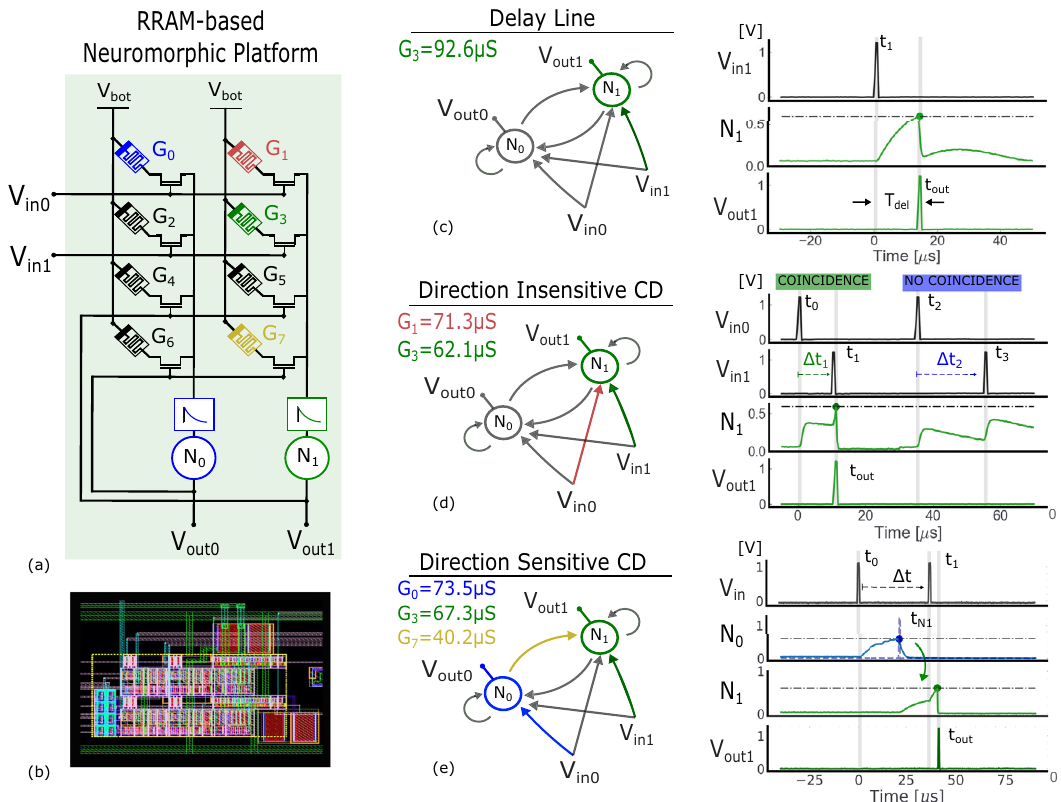
Fig. 4 Experimental measurements of the RRAM-based neuromorphic circuital platform. a Diagram of the circuit formed by two output neurons, N 0 and N fi ne the synaptic connections from inputs to outputs and the four cells on the 1 , receiving two inputs 0 and 1. The four devices on the top of the array de bottom de fi ne the recurrent connections among neurons. Colored RRAMs represent devices set in the HCS on the diagrams to the right: a device in the HCS allows a connection to be formed and expresses a weight, while a device in the LCS blocks the input pulse and disables the connection to the output. b Layout of the circuit in ( a ), with the eight RRAMs highlighted in blue. c A delay line is formed by simply exploiting the dynamics of a DPI Synapse and a LIF Neuron. The green RRAM is set to high enough conductance to allow the output spike to be elicited following the input spike by a delay Δ t . d Diagram of the direction insensitive CD detecting temporally correlated signals. The output neuron 1, N 1 , spikes upon arrival of input 0 and input 1 with small delay. e Diagram of the direction-sensitive CD, a circuit that detects when input 1 arrives in close proximity and after input 0. The output of the circuit is represented by neuron 1 ( N 1 ).